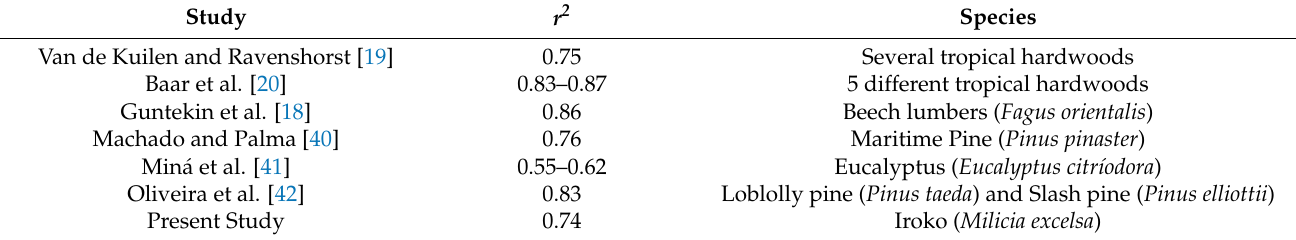
Table 10. Correlations between the dynamic modulus of elasticity obtained from UPV and the static modulus of elasticity, obtained by different studies. Study r